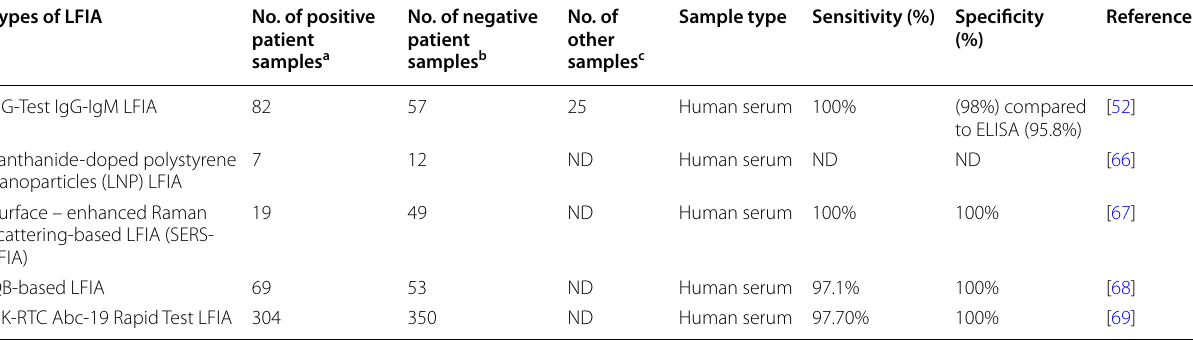
Table 1 Comparison of different types of LFIA tests developed for COVID-19 detection Types of